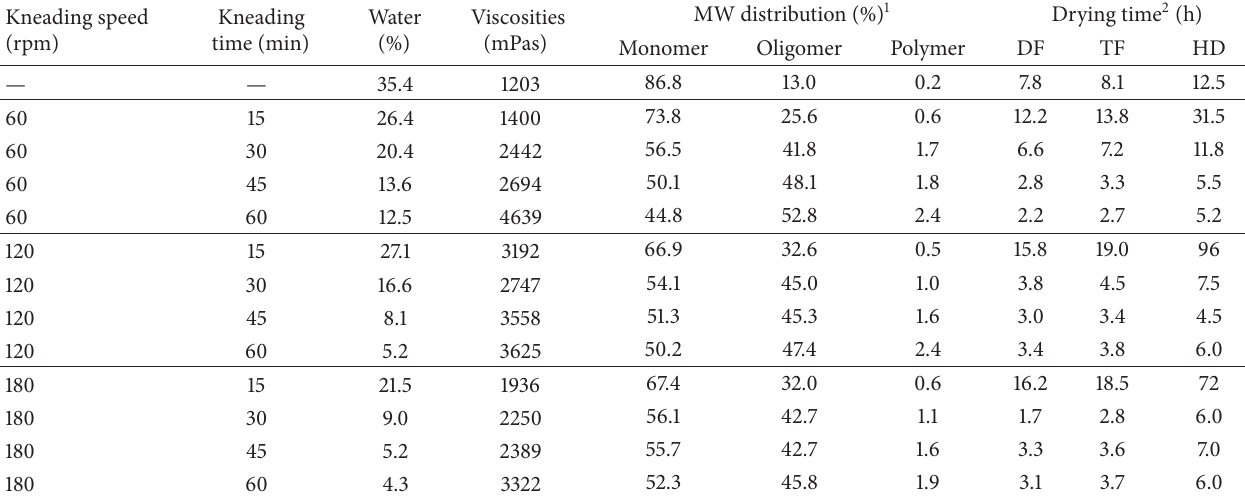
Table 5: Data results of kneaded lacquers.